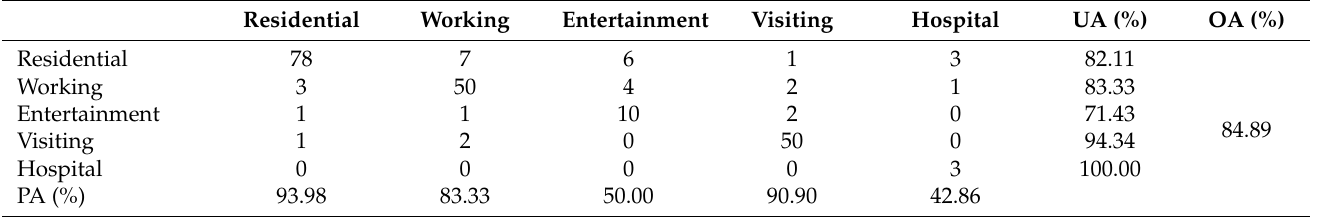
Table 7. The confusion matrix of the MS-RF model-predicted BFTs for the 10 independent experiments with the prediction accuracy ranked 5th.